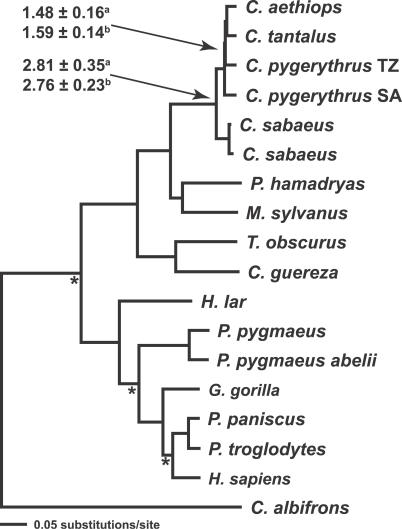
Relaxed Molecular Clock Analysis of Catarrhine Taxa with Estimated AGM Divergence DatesML tree is rooted using C. albifrons as an outgroup, with mean MRCA date for the AGM taxa and 95% confidence intervals estimated from 100 replicate trees from (a) ML bootstrap analysis and (b) Bayesian MCMC analysis. Asterisks designate nodes as being fossil-constrained as defined by Raaum et al. [42].